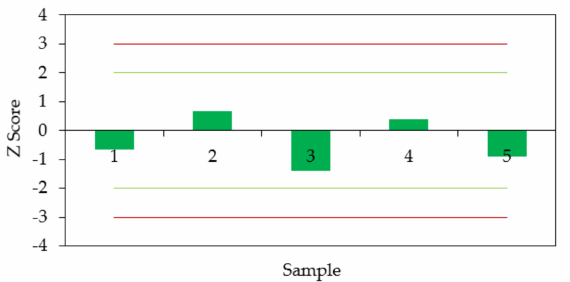
Figure 11. Z Score values obtained for the different concentrations during the second field trial, using the formulation given by EN 13528; in this case, the value of standard deviation selected is 10% of the expected